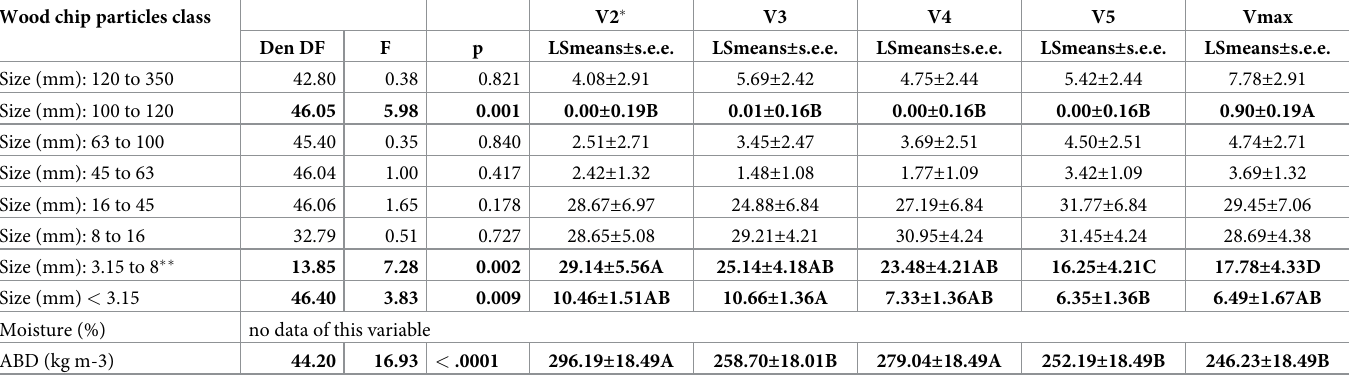
Table 7. Quality of the chipped material at varying the counter rotating roller speed in the Helicoidal knives (c_HEL) treatments only. Treatments with Hoe shaped knives (d_HSK) were not included in the analysis because not direct comparison (i.e. at least 2 different speed in the same species) were available. Quality traits were the size distribution of the material and the apparent bulk density (ABD). The mean moisture was not available. Fractions varying at p > 0.05 are shown in bold. Within each fractions, LSmeans with a letter in common can’t be considered different according to a lines-display of the ranked p-differences adjusted by Tukey Kramer for multiple comparisons. The estimated denominator degrees of freedom (DEN DF) after the Kenward Roger correction is shown, along with F and p values. Wood chip particles class V2 �